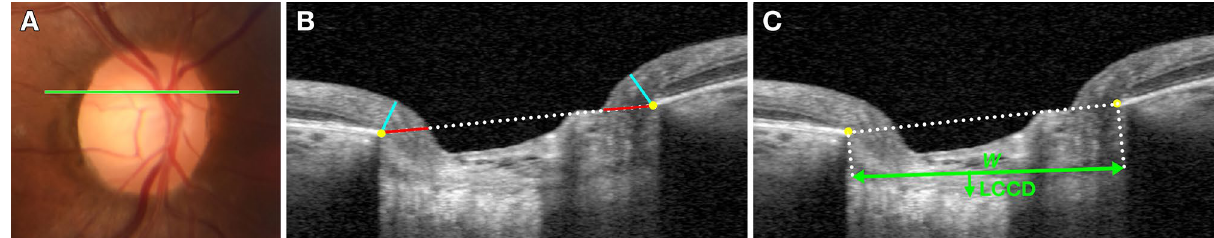
Figure 5. Measurement of optic nerve head indices. ( A ) Color disc photograph; the horizontal green line indicates the plane in which the measurements were made. ( B ) B-scan image obtained at the location indicated by the green line in ( A ). Horizontal rim width (HRW; red line) and minimal rim width (MRW; turquoise line) were measured at the temporal and nasal rims. The HRW was defined as the distance between the projection of Bruch’s membrane opening (BMO, yellow glyphs) to the BMO reference plane and the internal limiting membrane (ILM) along the BMO reference plane. The MRW was defined as the minimum distance between the BMO and the ILM. ( C ) Same image as in ( B ). The lamina cribrosa curvature index was measured by dividing the lamina cribrosa curve depth (LCCD; arrow) within the BMO (yellow glyphs) by the width (W; double- headed arrow) of this opening and then multiplying by